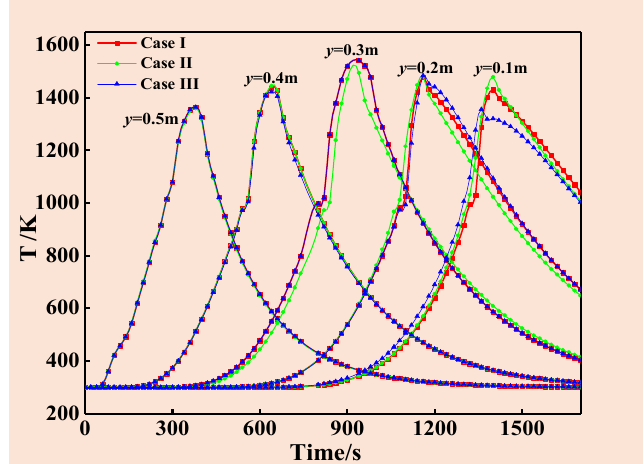
Figure 16. Temperature evolution curves of Case I, II and III.